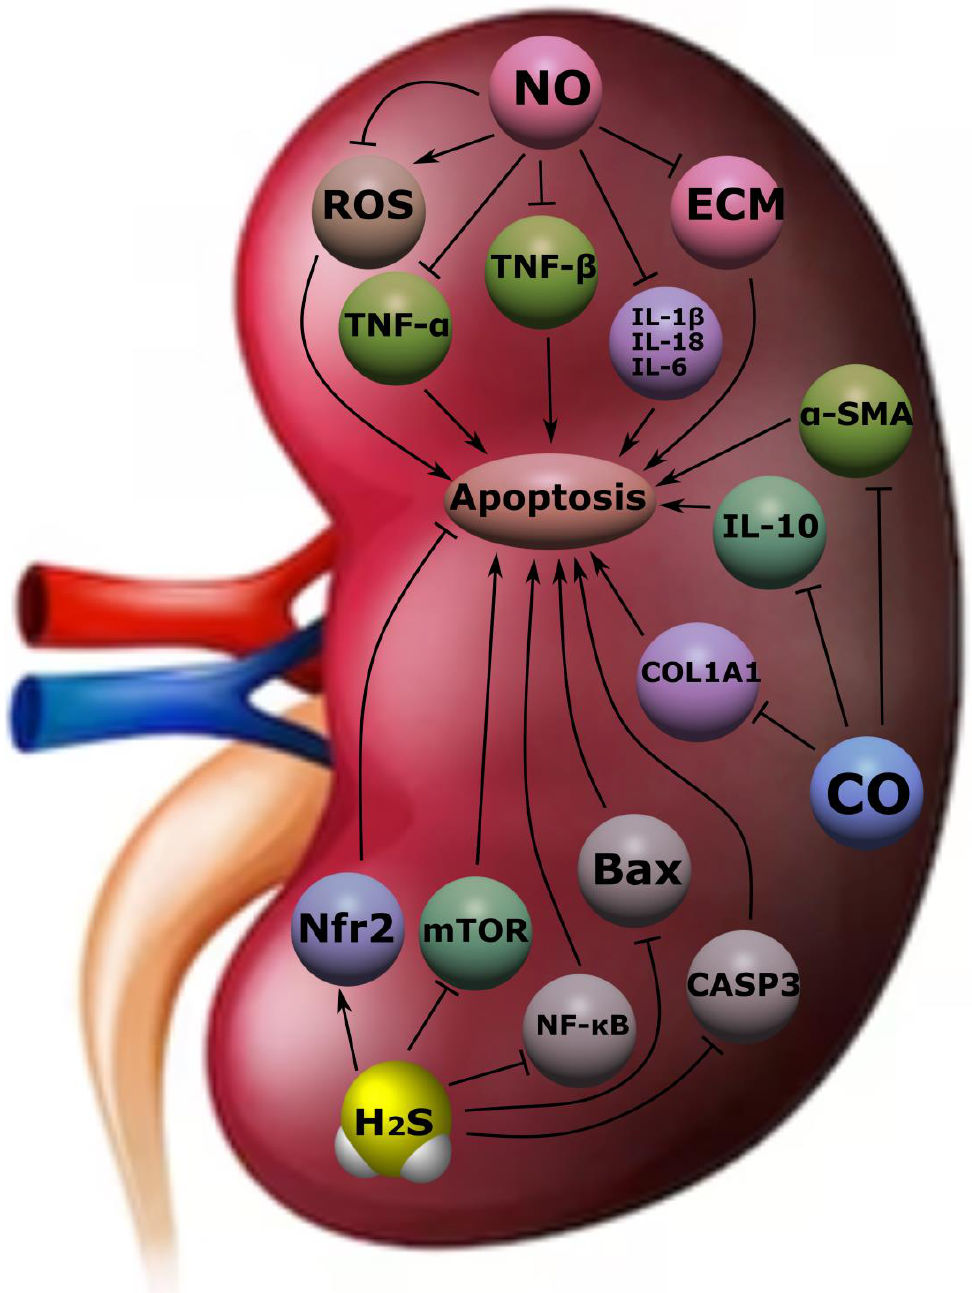
Figure 8. Possible gasotransmitter-dependent signaling mechanisms regulating apoptosis in kidney diseases. NO, nitric oxide; CO, carbon monoxide; H 2 S, hydrogen sulfide; ROS, reactive oxygen species; TNF- α and TNF - β , tumor necrosis factors; ECM, extracellular matrix; interleukins, IL- 1β, IL-18, IL-10, and IL- 6; α -SMA, smooth muscle alpha-actin; COL1A1, type 1 collagen; Bax, bcl-2-like protein 4; Nfr2, nuclear factor erythroid 2-related factor 2; mTOR, mammalian target of rapamycin; CASP3, cysteine-aspartic acid protease 3; NF- κB , nuclear factor kappa-light-chain-enhancer of activated B cells. Arrows with a sharp end — positive regulation; arrows with a blunt end — negative regulation.